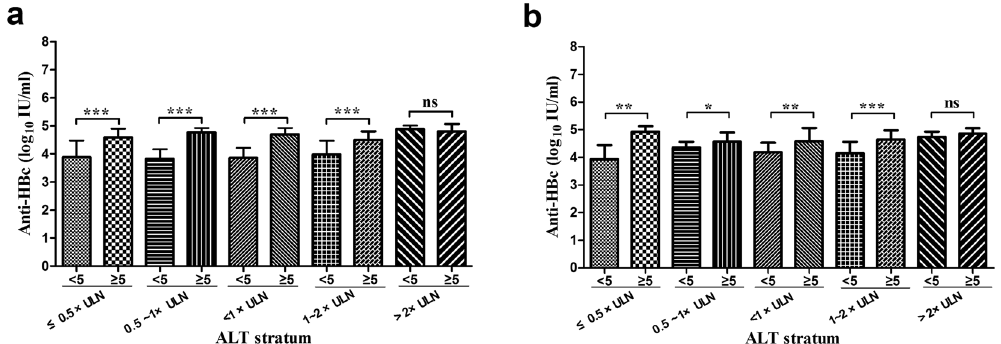
(Table 3). In HBeAg ( − ) CHB patients, the univariate analysis identified anti-HBc, AST and GGT were significantly